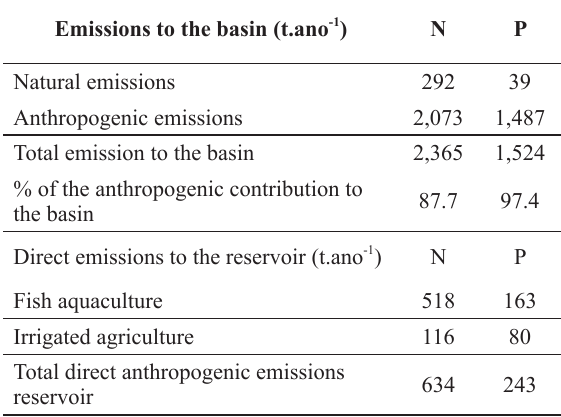
Comparison of natural and anthropogenic emissions of nitrogen (N) and phosphorus (P) (t.ano -1 ), estimated using emission factors, to the Castanhão Reservoir Basin (Avelino